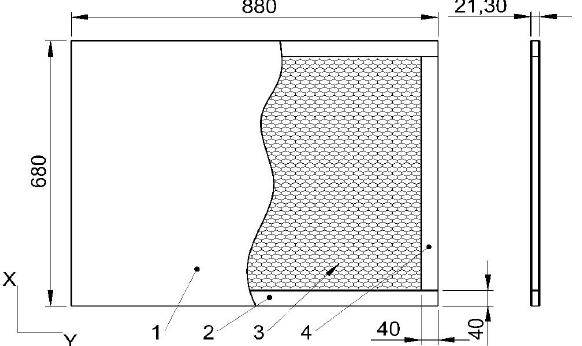
Figure 2. Dimensions and structure of the honeycomb panel sheet: 1—facing, 2—honeycomb core, 3—horizontal stile, 4—vertical stile. Panels thickness equal to 20.3 mm, 21.3 mm, 22.3 mm for H20, H25, P30, respectively.